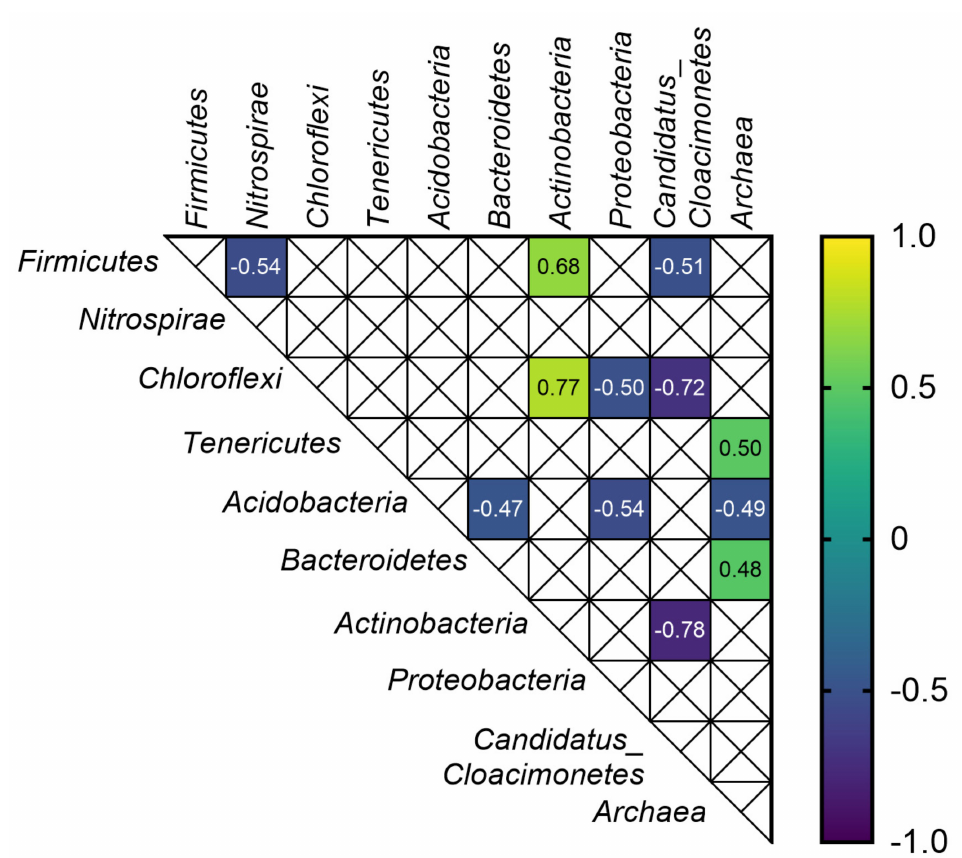
Figure 6. Significant correlations between dominant microorganisms in the process bioreactor. Positive correlations are marked in green, and negative correlations are marked in blue. Color intensity is proportional to the correlation